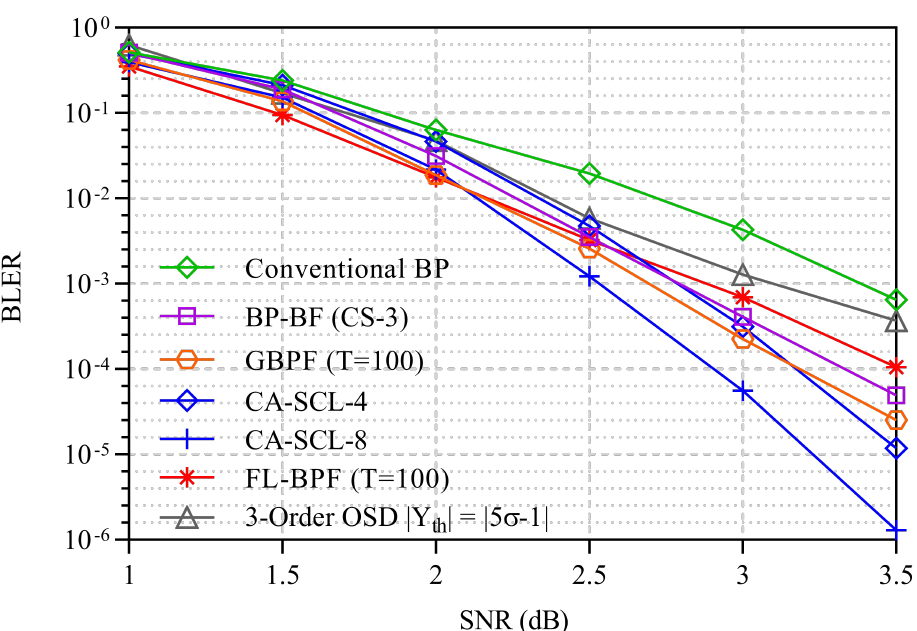
Figure 5. BLER performance of BP, BP-BF(CS-3), GBPF, CA-SCL, and the proposed technique for P ( 512,256 )